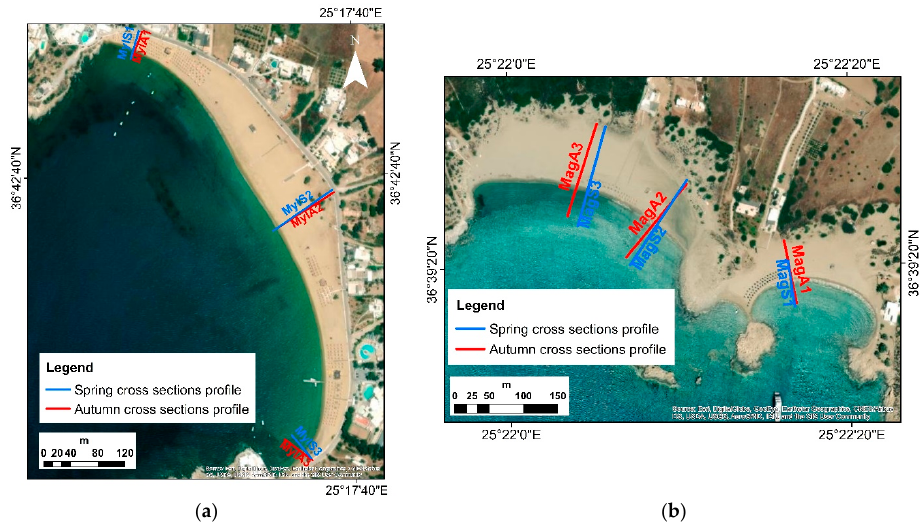
Figure 13. Cross-sections of Mylopotas and Magganari: ( a ) For Mylopotas, cross-sections MylS1, MylS2 and MylS3 for the spring study period and cross-sections MylA1, MylA2 and MylA3 for the autumn study period; ( b ) For Magganari, cross-sections MagS1, MagS2 and MagS3 for the spring study period and cross-sections MagA1, MagA2 and MagA3 for the autumn study period. In more detail, at the NW part of Mylopotas beach, the cross-section MylS1 presents a gentle slope, which at a distance of 5 m from the shoreline, becomes steep with the ap- pearance of a 1.56 m deep graben. The MylA1 section is also characterized by a gentle slope and the distinct presence of a berm zone approximately 5 m landward from the coastline. The subsea section is characterized by a gentle slope. The prevailing beach ma- terial for both study periods is characterized by slightly gravelly sand, moderately sorted (Figure 14a,b).